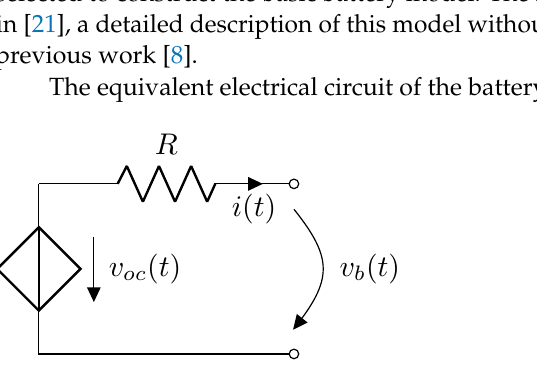
Figure 1. Equivalent electrical circuit model of the battery. Voltage v oc ( t ) of the controlled voltage source is different in the case of charge and